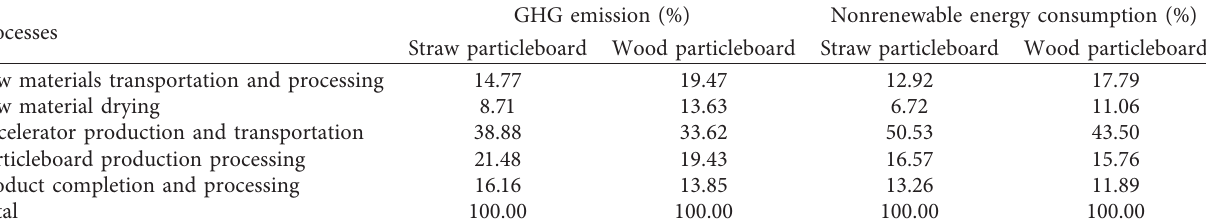
Table 9: Comparative contribution to the production of straw and wood particleboard.